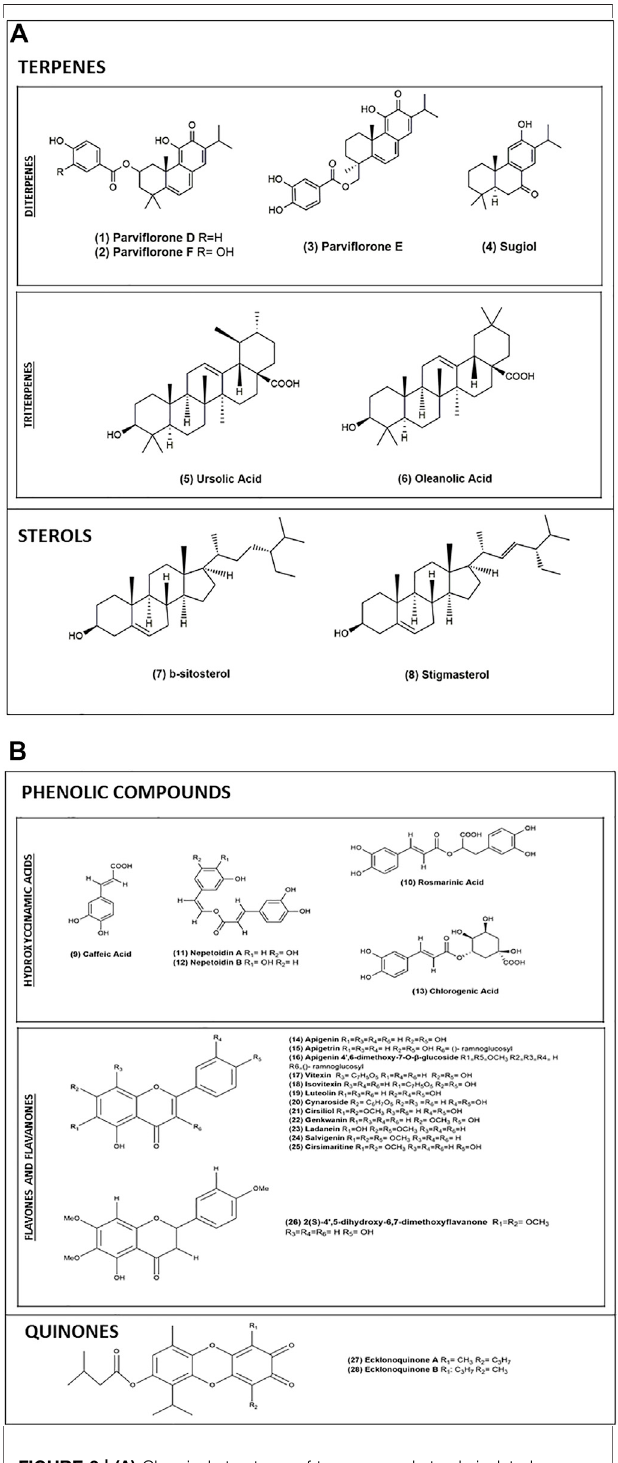
FIGURE 3 | (A) Chemical structures of terpenes and sterols isolated from P. ecklonii . (B) Chemical structures of phenolic compounds and quinones isolated from P. ecklonii